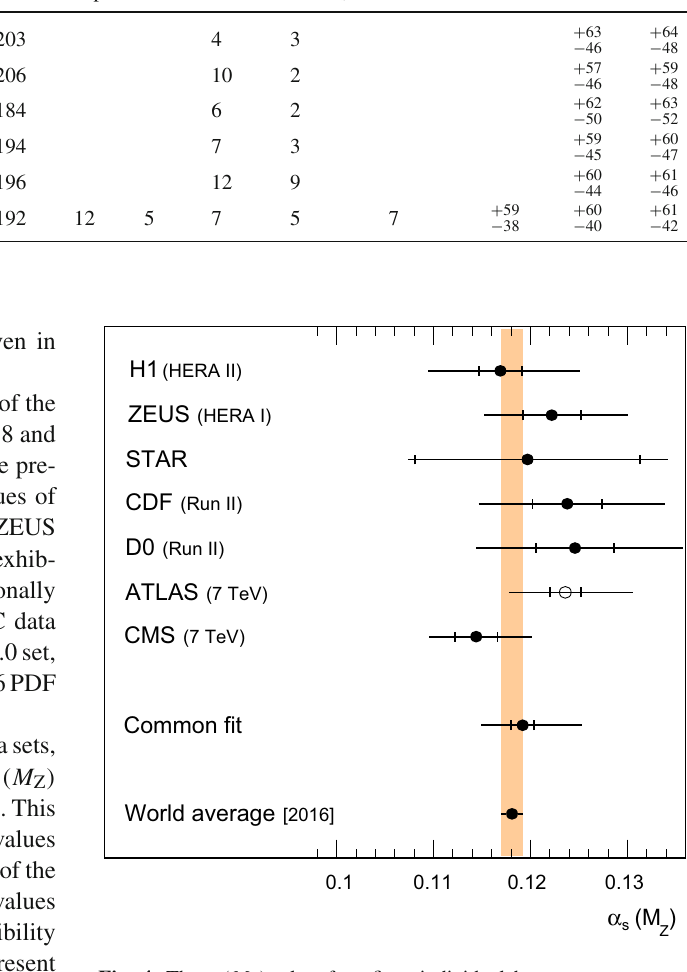
Fig. 4 The α s ( M Z ) valuesfromfitstoindividualdatasetsarecompared to our simultaneous fit to H1, ZEUS, STAR, CDF, D0, and CMS data, and to the world average value [1]. The inner error bars represent the experimental uncertainty and the outer ones the total uncertainty. For reasons explained in the text, the ATLAS data are excluded from the common fit and only the result of a separate fit is indicated by the open circle PDF 2 and PDF α s uncertainties as appropriate for the respec- tive PDF set. The values of χ 2 / n dof for the main PDF sets can be read off from row six of Fig. 3